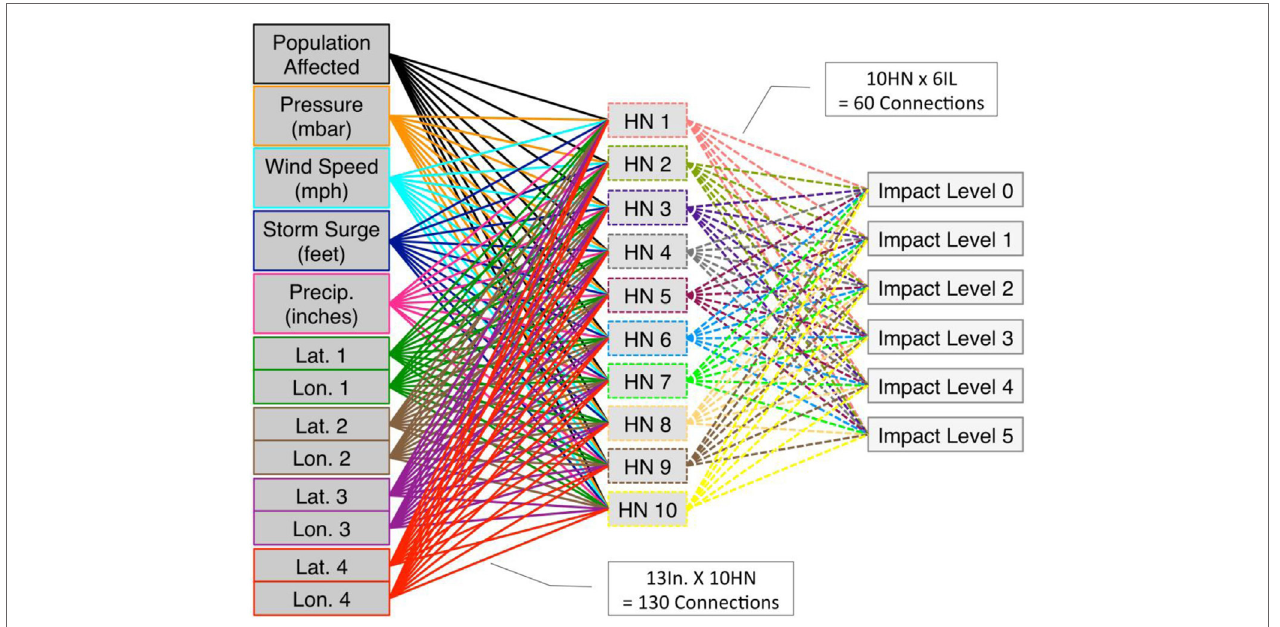
FigUre 1 | Hurricane Impact Level (HIL) Model neural network general structure (Lat. = latitude in degrees North, and Lon. = longitude in degrees West, HN = hidden neuron, units are shown as those in use within the HIL